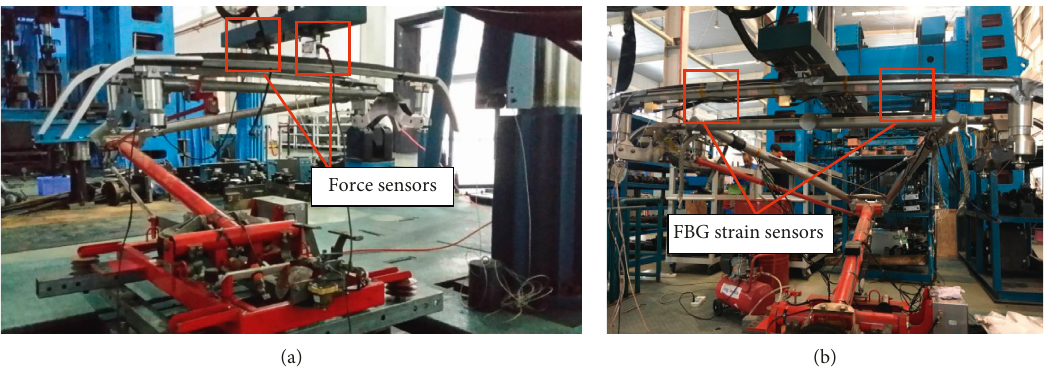
Figure 4: Pantograph in the dynamic